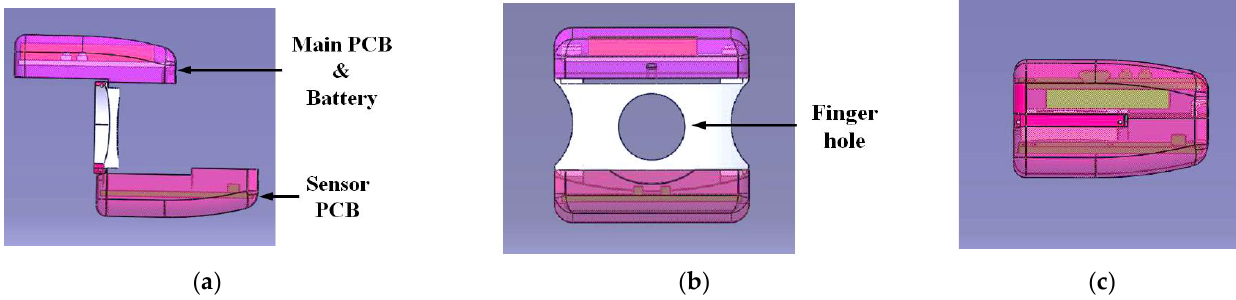
Figure 7. Pictures of 3D models of the proposed finger-ring-shaped smart stethoscope: ( a ) side view in user mode; ( b ) front view in user mode; ( c ) side view in collapsed mode.